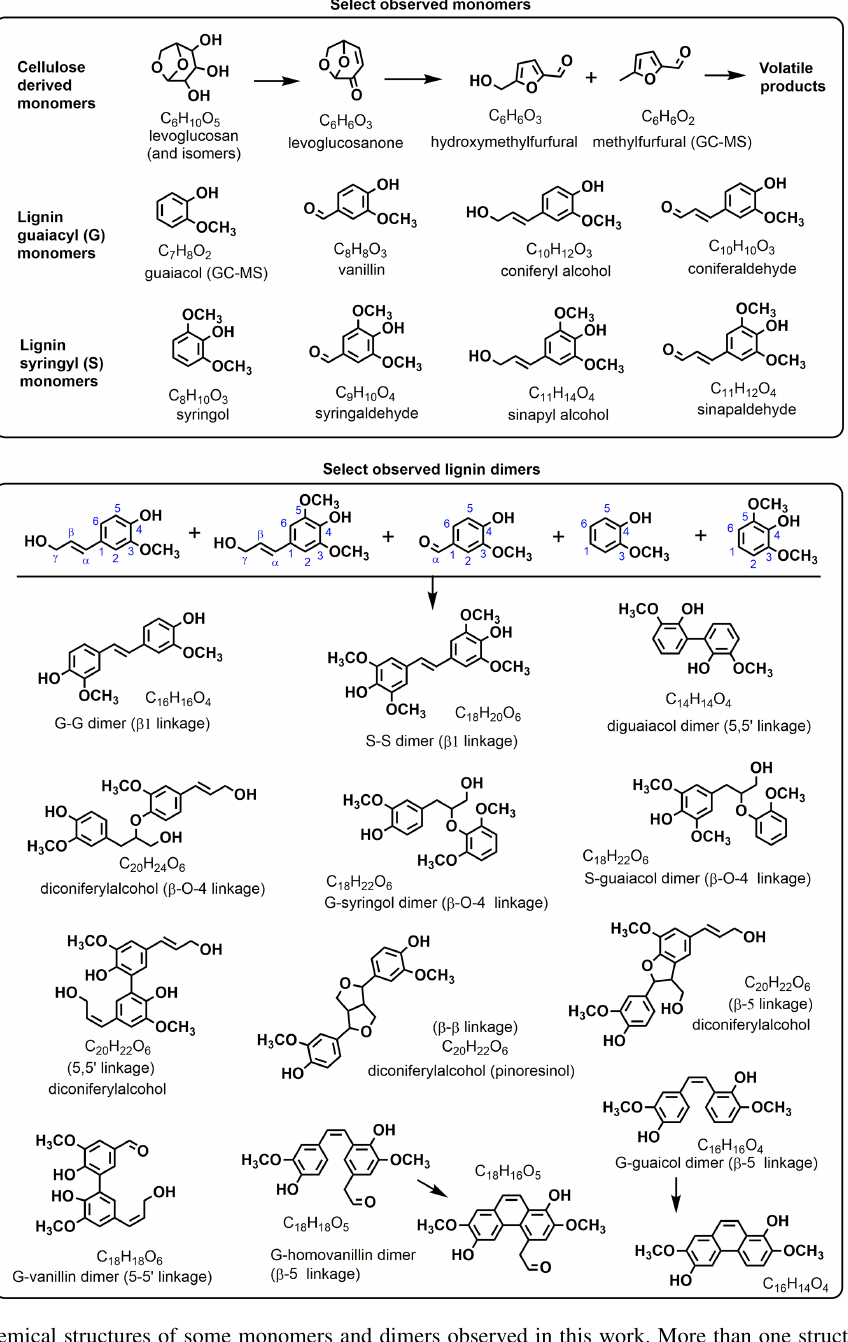
Figure 4. Proposed chemical structures of some monomers and dimers observed in this work. More than one structure may be present at each molecular